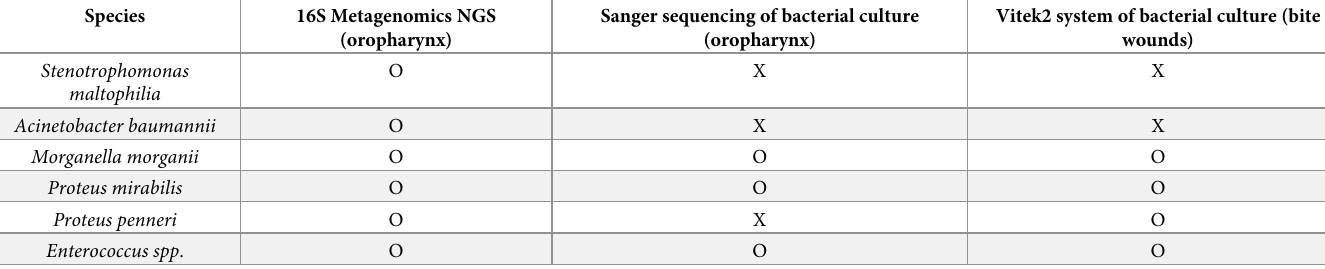
Table 4. Identification of the bacterial species in N. atra oropharynx and bit wounds.